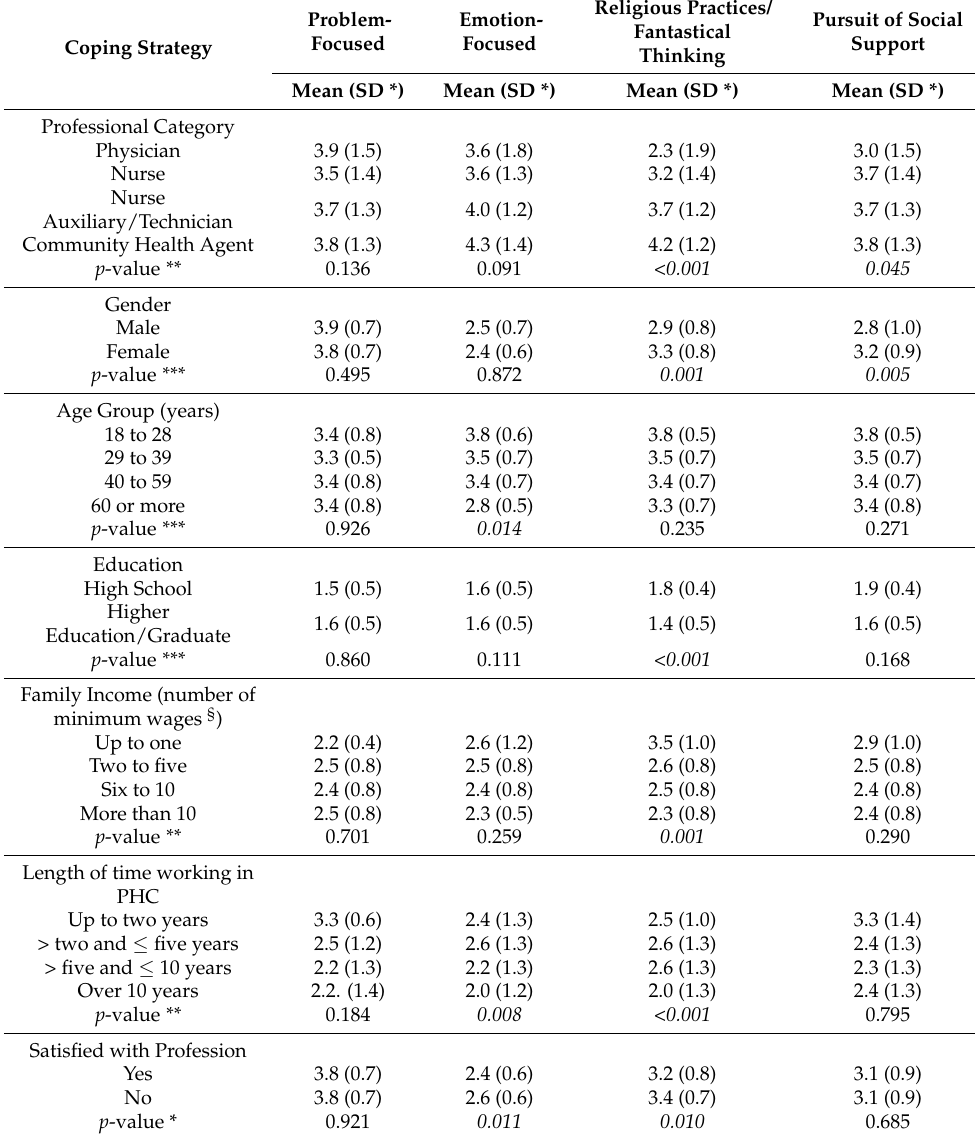
Table 3. Mean scores of the coping strategies of PHC workers, according to sociodemographic and professional variables. S ã o Jos é do Rio Preto, S ã o Paulo, Brazil.